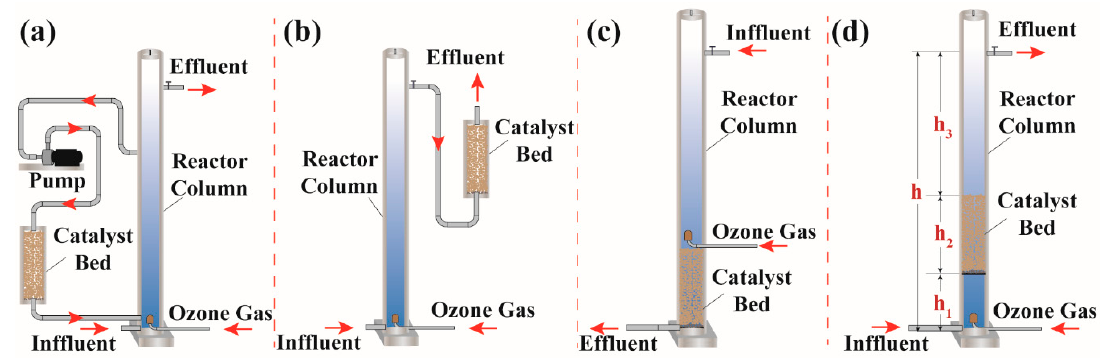
Figure 2. Catalytic ozonation reactors, ( a ) the three-phase bypass internal circulation reactor (TR), ( b ) the sequential flow series reactor (SR), ( c ) the gas-liquid countercurrent reactor (CR), and ( d ) the integral reactor with catalytic ozonation stacked by ozone absorption (IR).